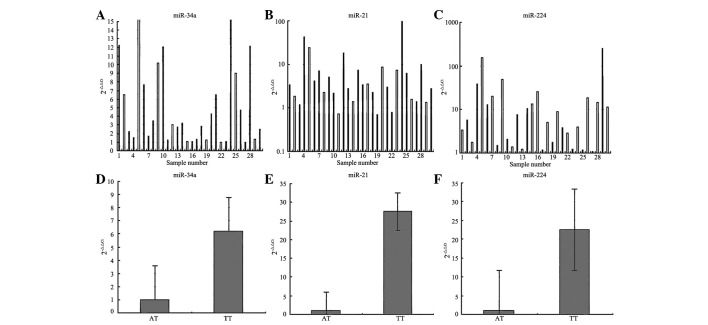
Individual (A, B, C) and general (D, E, F) relative quantification for miR-34a, miR-21 and miR-224 in tissue samples from patients with clear cell renal cell carcinoma (ccRCC). AT, adjacent tissue; TT, tumor tissue.